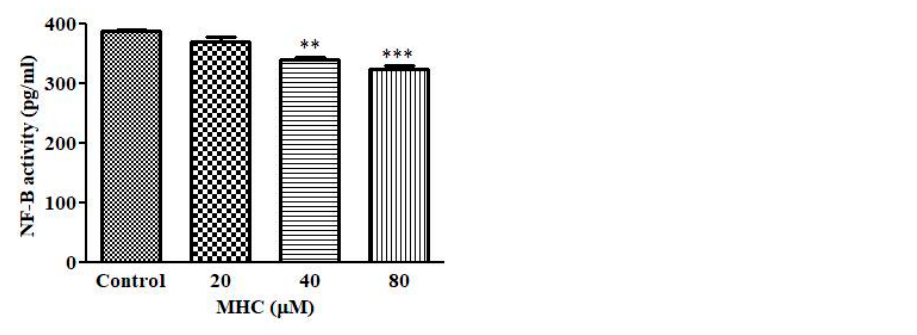
Figure 8. Alterations in the levels of NF- κ B post-exposure with MHC . ** p < 0.01 and *** p < 0.001